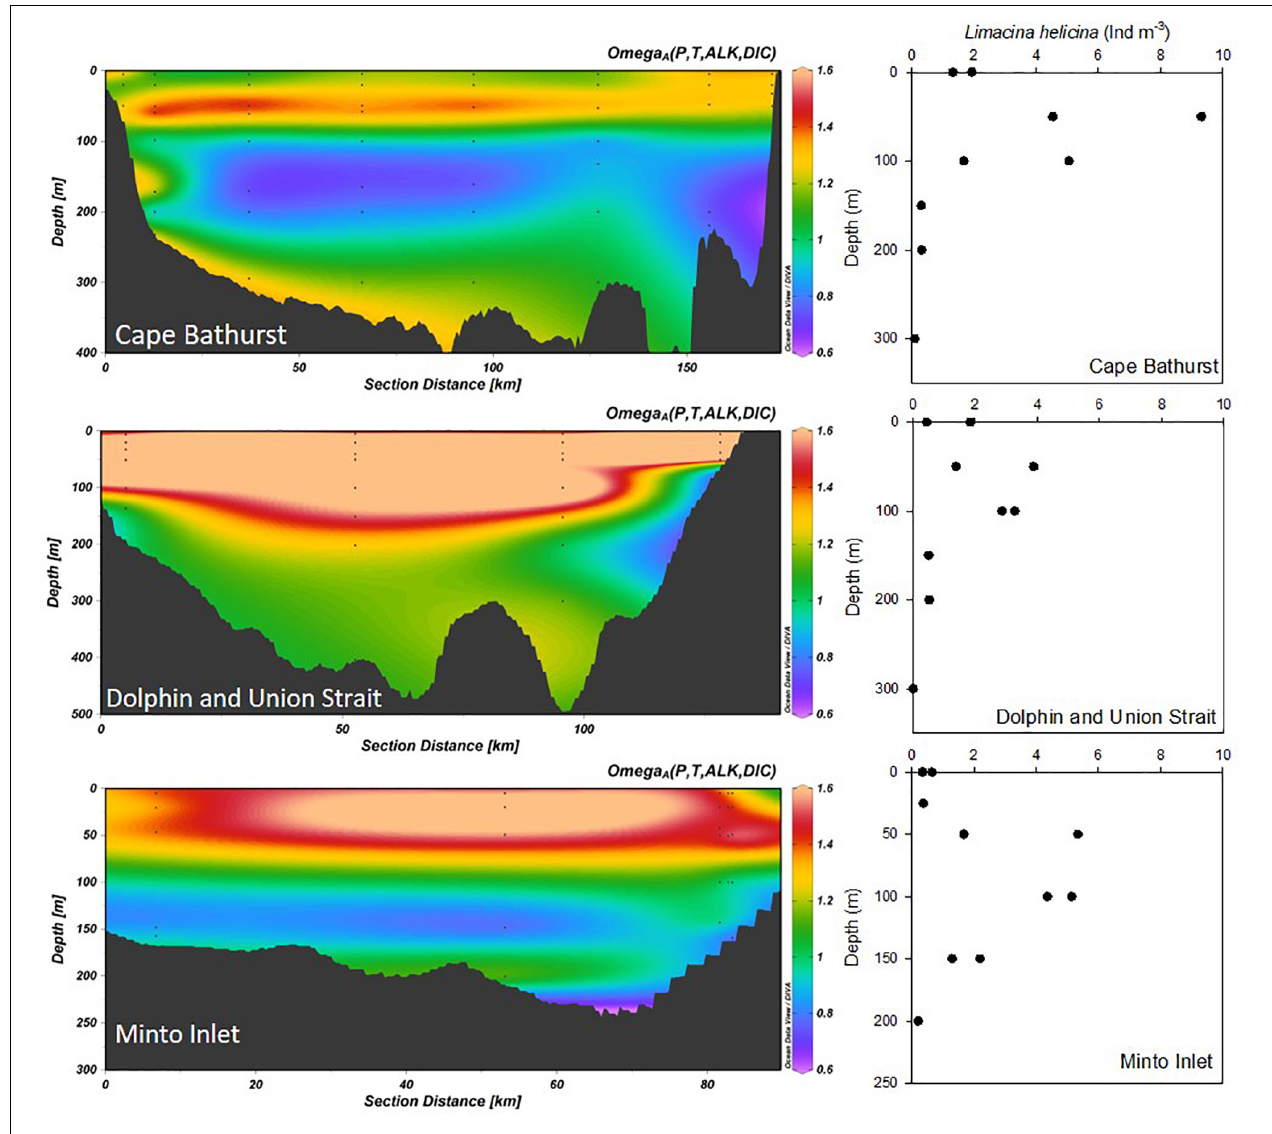
FIGURE 3 | Aragonite saturation (Omega) and Limacina helicina abundance (Ind. m − 3 ) at Cape Bathurst (CPB), Dolphin and Union Strait (DUS), and Minto Inlet (MTI) in 2017. Sections correspond to 2017 transects in Figure 1 , running from the SW to